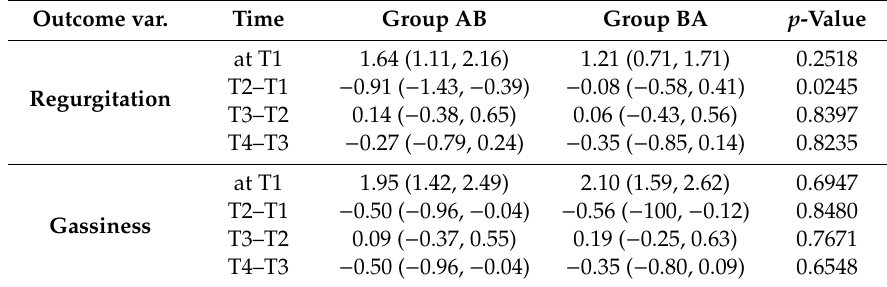
Table 4. Changes in regurgitation and gassiness between visits. T1: Initiation of first formula, T2: Follow-up of first formula, T3: Initiation of second formula, T4: Follow-up of second formula. Outcome var. Time Group AB Group BA p